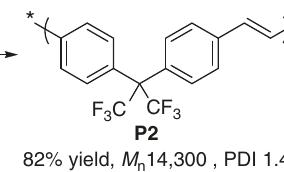
Fig. 5 Synthesis of polymer P2 . The polymer generated has a C(CF 3 ) 2